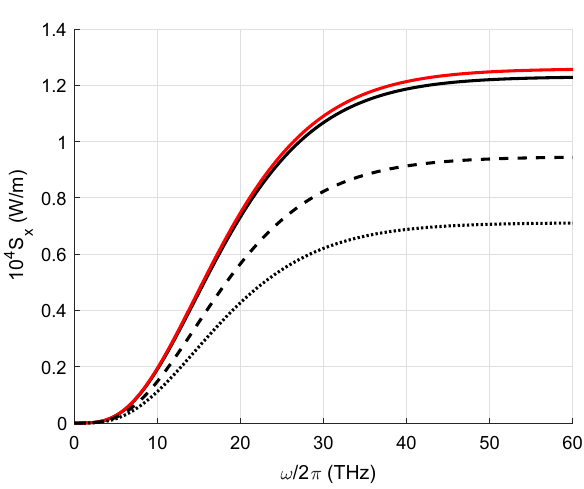
12 . The solid black curve =